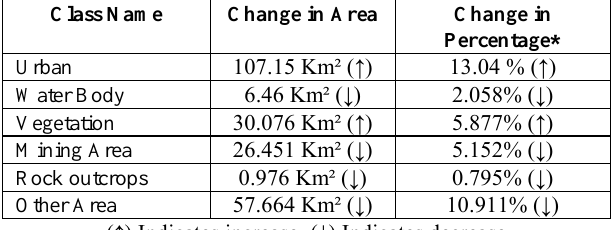
Table-7. Land cover/land use classes and change